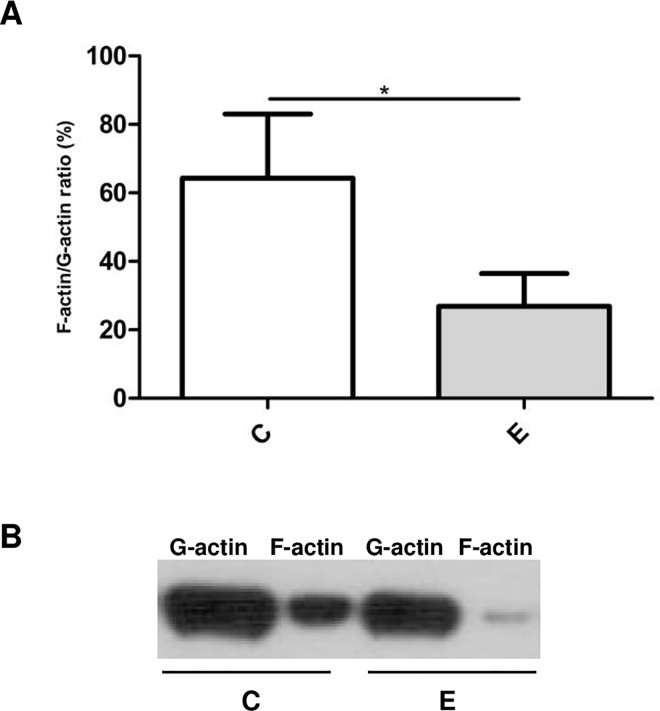
Quantitation of the globular / fibrillar actin ratio (G-actin / F-actin) in HUVEC following incubation with 3 μM β-escin.A. Data shown were obtained in three independent experiments performed with cells from five donors. The paired t-test (GraphPad Prism v.6.01) was used for statistical analysis. *p < 0.05. B. Typical assay results showing changes in the amount of G-actin and F-actin in HUVEC treated with 3 μM β-escin. Abbreviations: C—untreated HUVEC; E—β-escin treated cells.